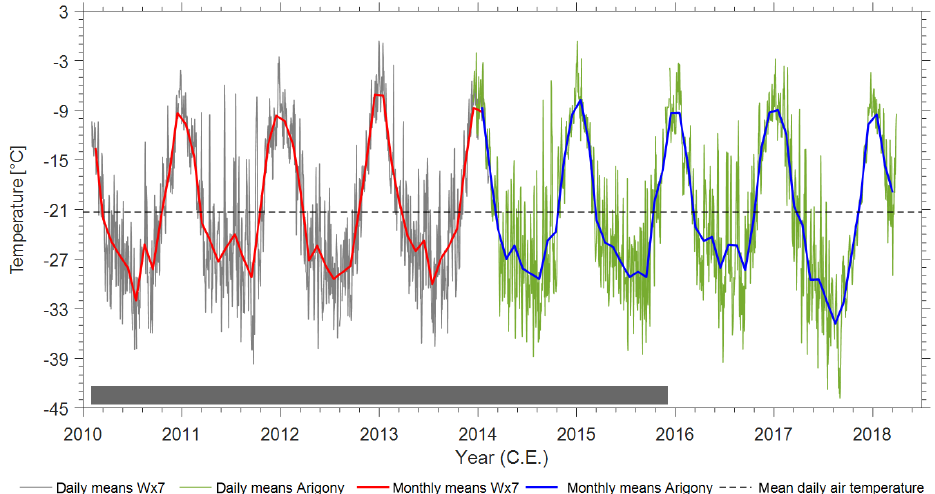
Figure 4. Composite record of mean daily and mean monthly air temperatures recorded at two nearby UG AWS sites (stations: Wx7, Arigony) from February 2010 to March 2018. The mean daily air temperature for the entire composite record period ( − 21 . 3 ◦ C; dashed black line) and the period overlapping with UG firn core records (February 2010 to November 2015; grey bar) are also